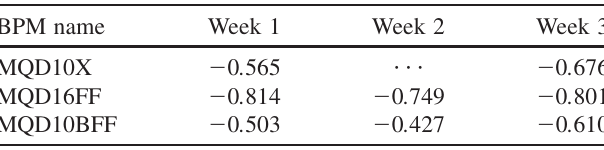
TABLE V. Vertical calibration phase rotation (cid:7) values over a 3 week